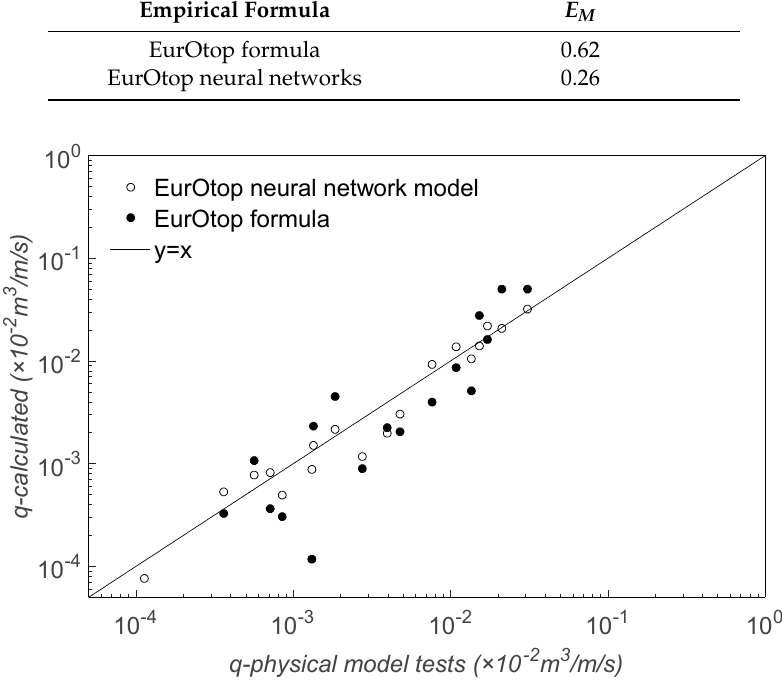
Figure 3. Comparison of different empirical formulas and physical model tests.